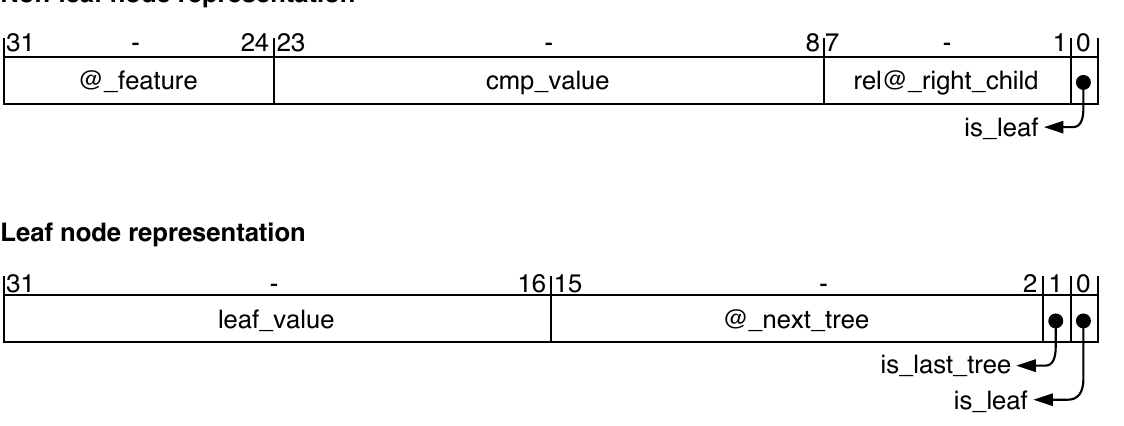
Figure 3. Node representation.